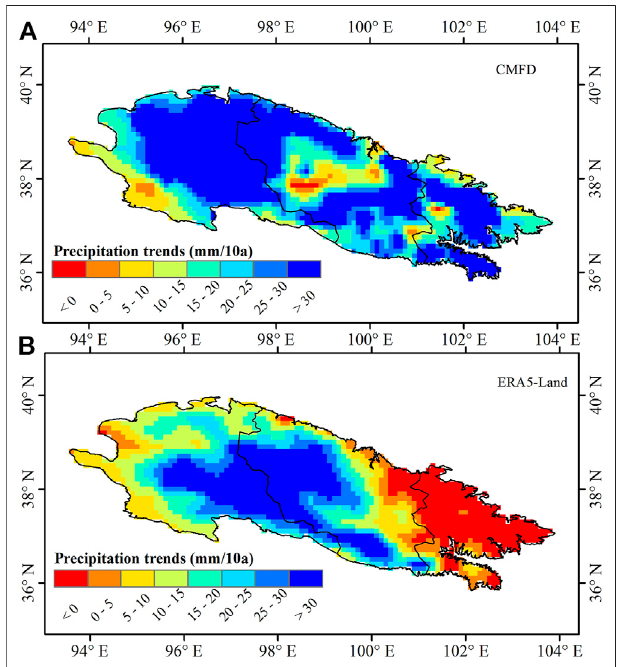
FIGURE 10 | Spatial distribution of precipitation climate tendency rate in the Qilian Mountains for the period 1980 – 2018, from CMFD (A) and ERA5- Land (B) .